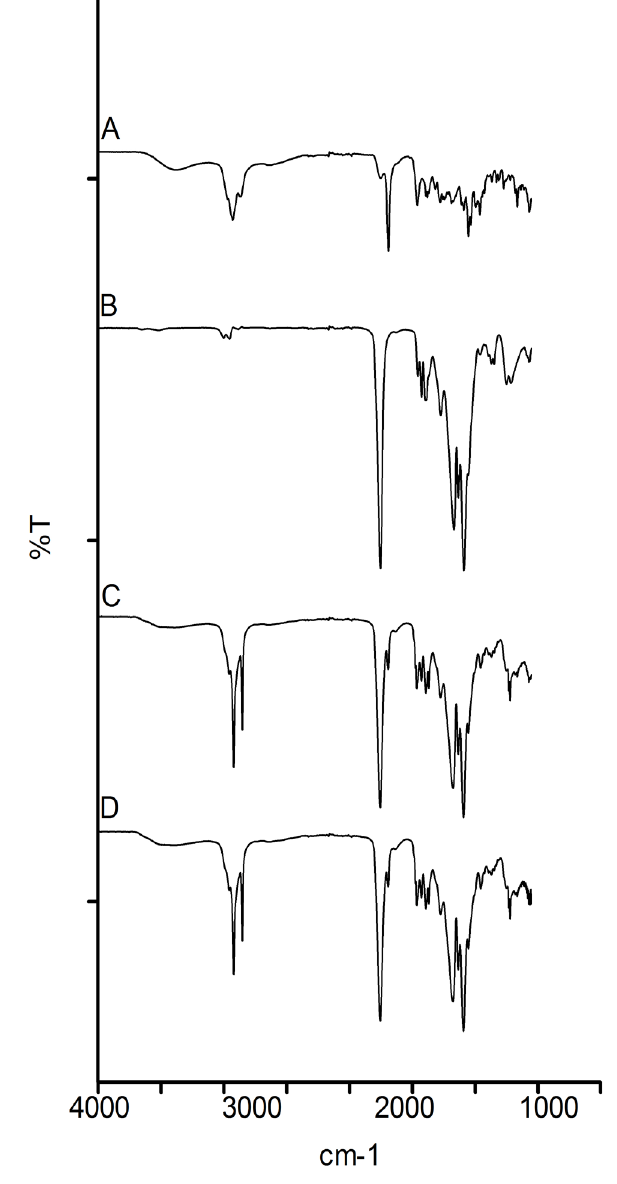
FIGURE 2 - FTIR spectra of CA (A), PLGA (B); physical mixture (C); CA-loaded PLGA implant